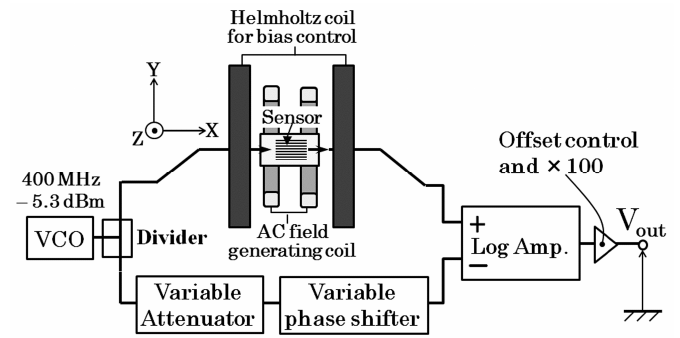
Figure 10. Measurement apparatus used in the sensitivity evaluation.